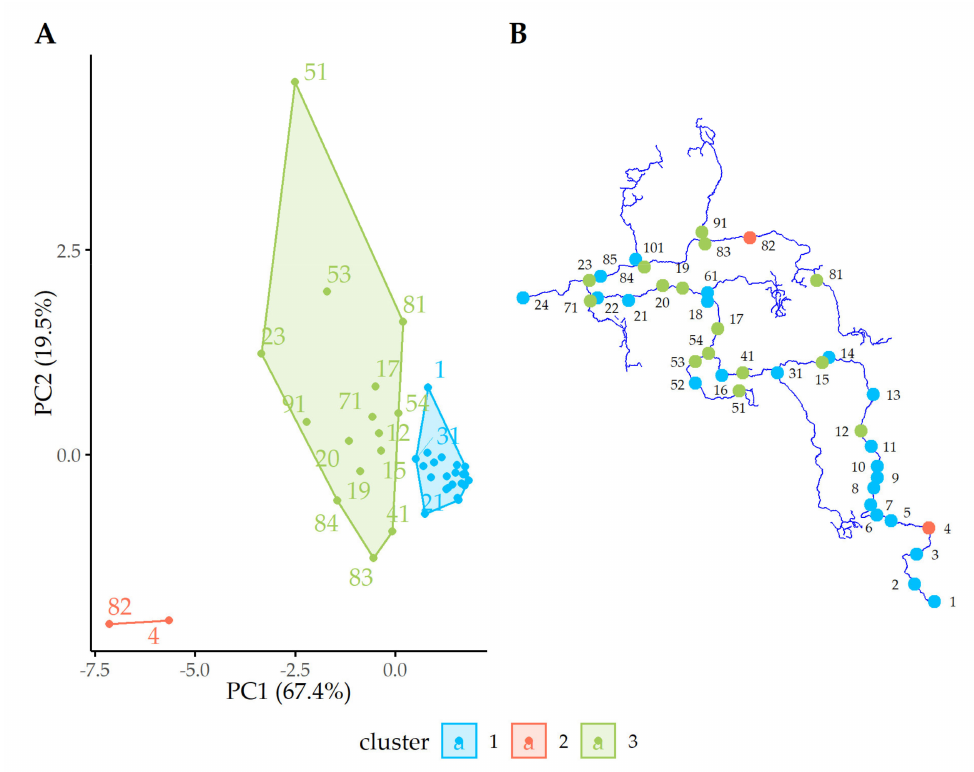
Figure 9. Partitioning clustering of sampling sites according to element concentrations in sediments ( A ) and location of points ( B ). Table 7. Eigenvalues, percent of variance and cumulative percent of variance for the PCA.